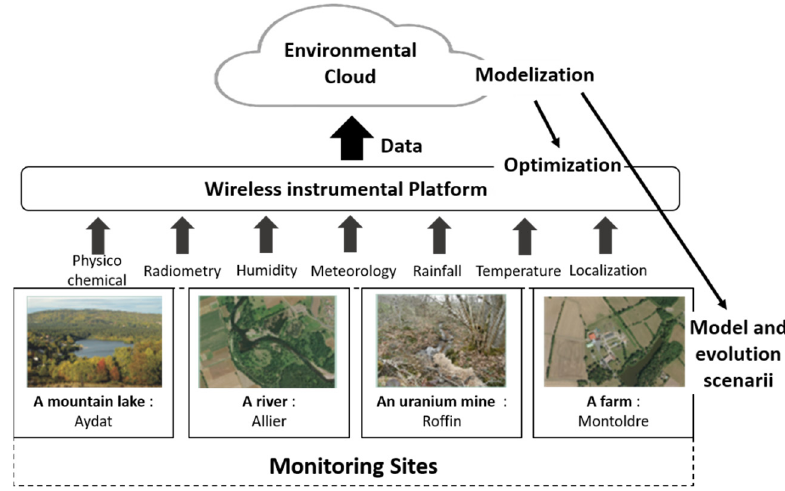
Figure 1. Synoptic of the network: Bring Water to Cloud .